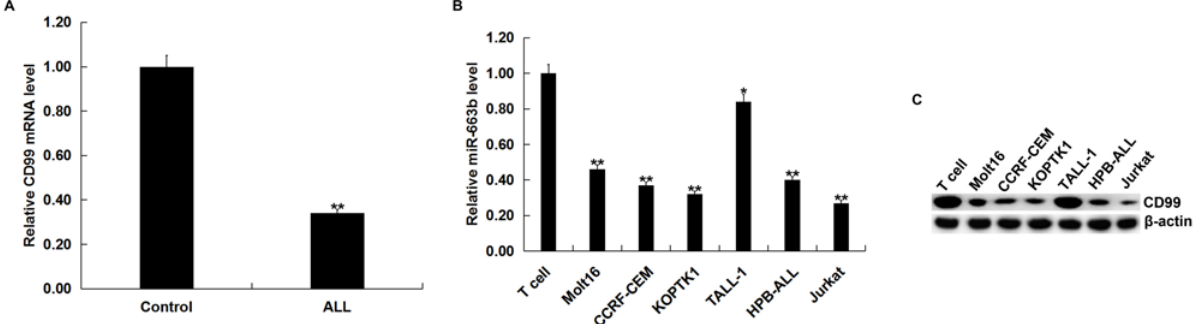
Figure 3: CD99 was down-regulated in human T-ALL cell lines and blood of pediatric T-ALL patients. (A). qRT-PCR assay detected the relative mRNA expression level of CD99 in blood of 30 cases pediatric T-ALL patients (ALL) and 30 cases healthy children (Control) (**p<0.01 vs. Control). (B and C) qRT-PCR assay and western blot assay assay detected the mRNA and protein expression level of CD99 in different human T-ALL cell lines and normal T cells. The data were expressed as the mean ± SD. *,**p<0.05, 0.01 vs. T